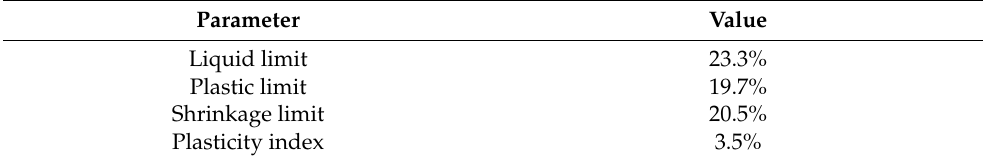
Table 3. The Atterberg limits of the tailings used.